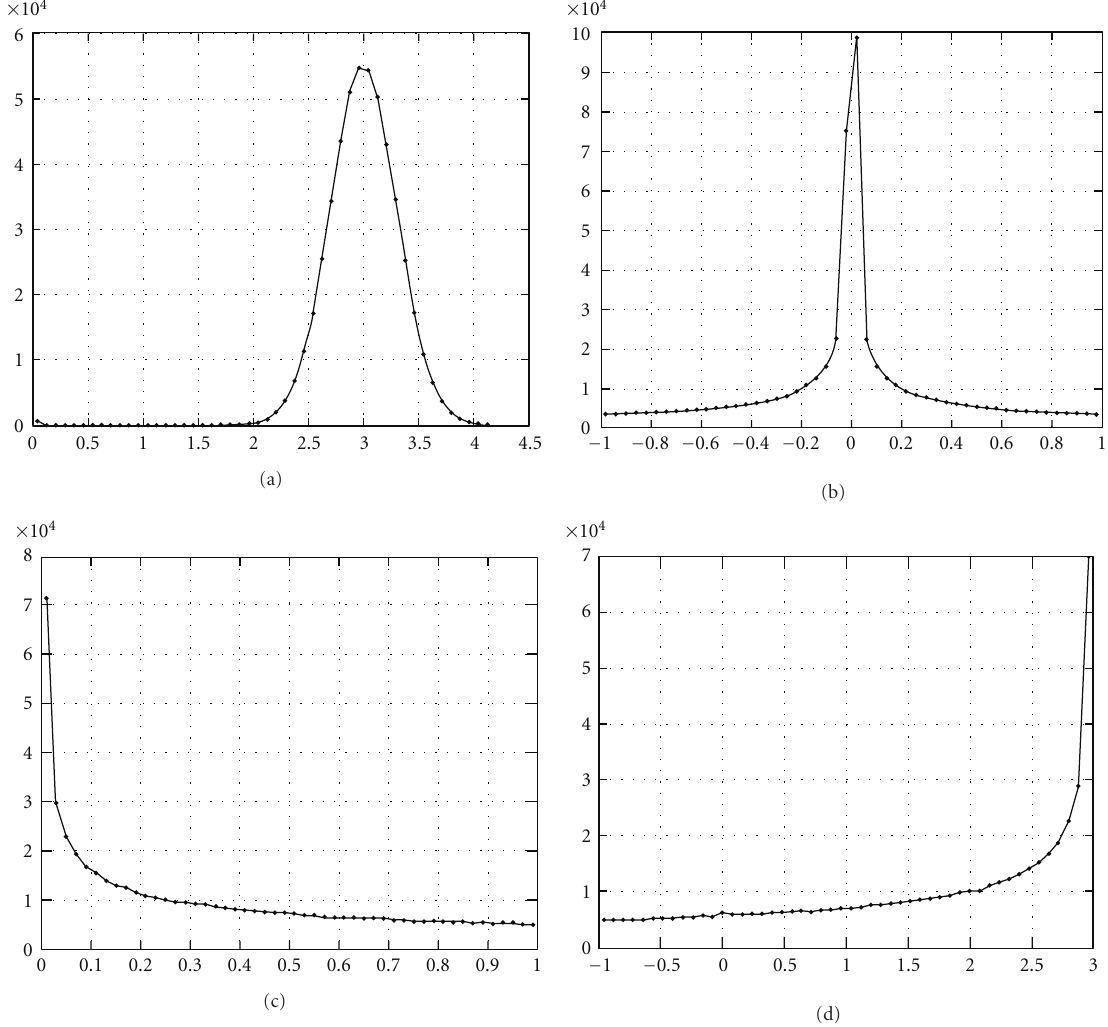
Figure 10: Probability density function (PDF) of the output signal obtained with the sampling scheme α and the following functions ((a) to (d)): Displaced Error Function (15), Cubic Function (18), first (19) and second Quadratic Function